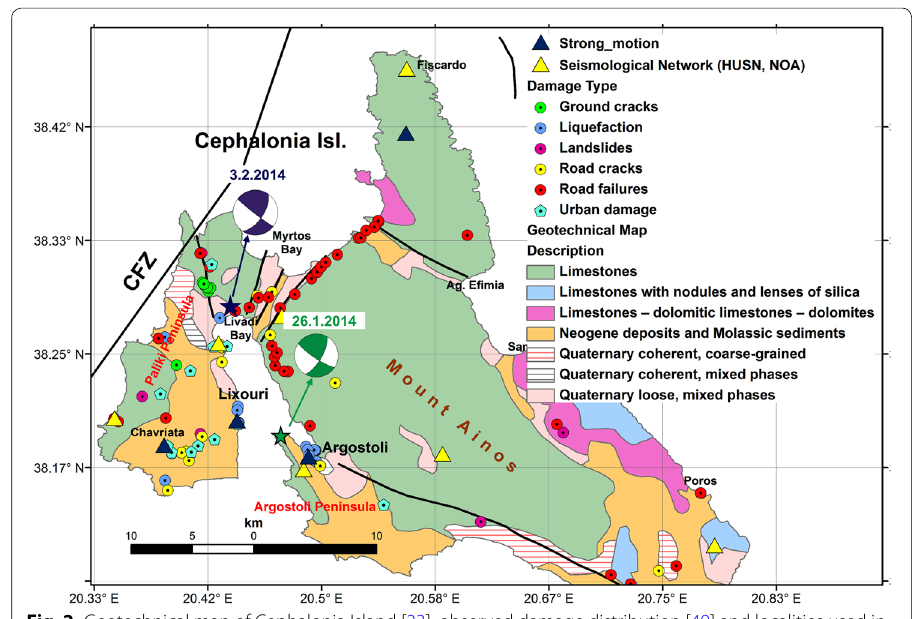
Fig. 2 Geotechnical map of Cephalonia Island [23], observed damage distribution [49] and localities used in the text. Recordings of the seismological instruments shown on the map were used in this work. Beach- balls denote the focal mechanisms of the 2014 major events [36]. CFZ Cephalonia Fault Zone; HUSN Hellenic Unified Seismological Network; ITSAK Institute of Engineering Seismology and Earthquake Engineering; NOA National Observatory of Athens—Institute of Geodynamics